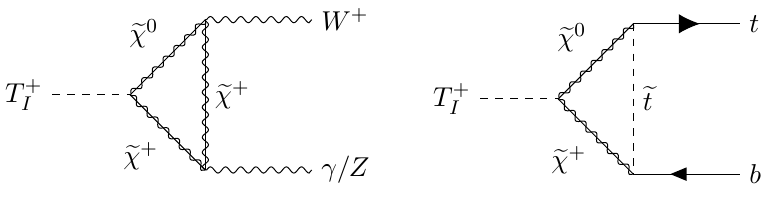
Figure 4 . The one-loop decays of the charged